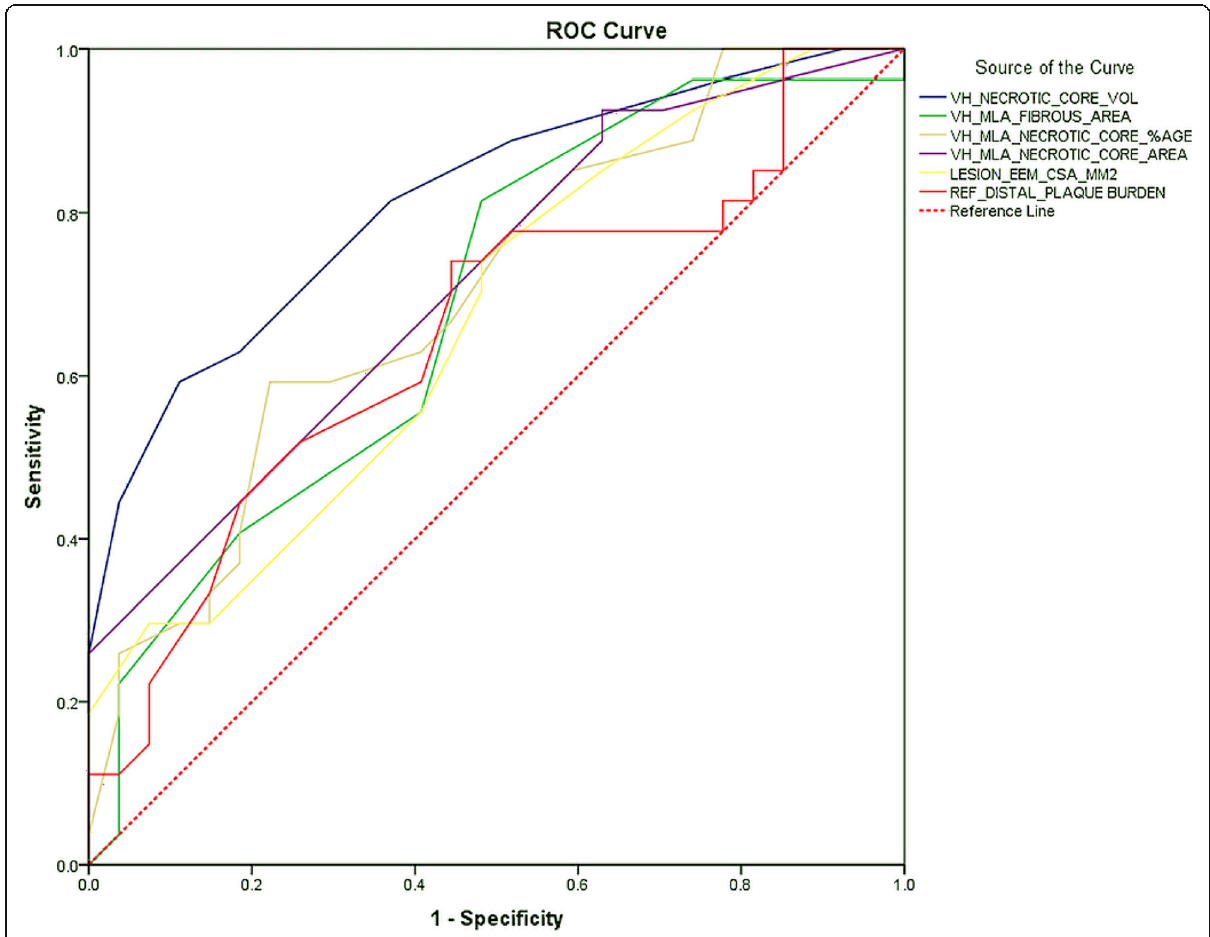
Fig. 4 Receiver operating characteristic (ROC) curves of the gray-scale and VH-IVUS parameters for the determinants of TIMI 1 – 2